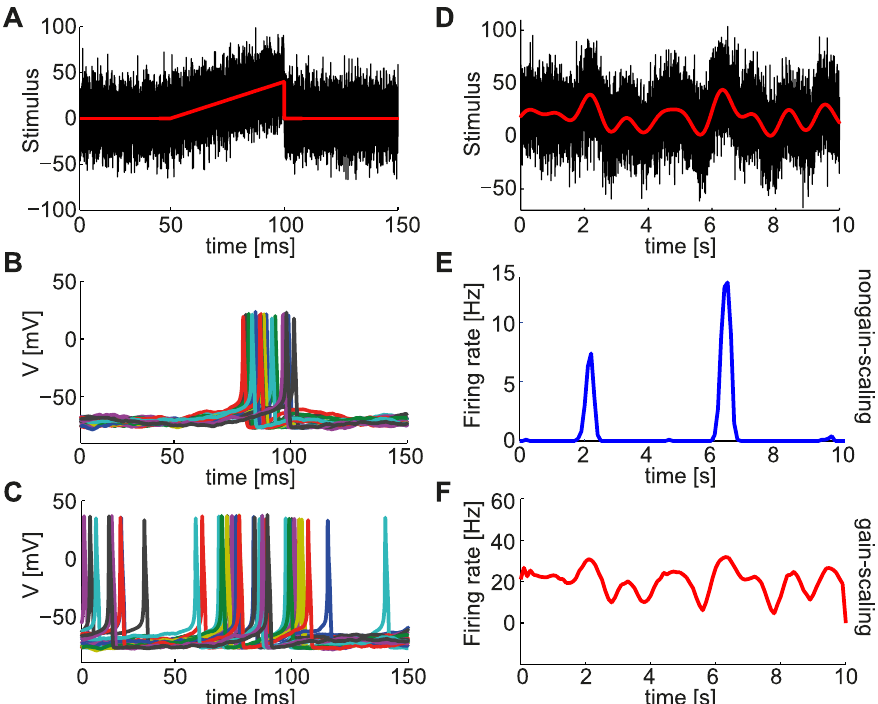
Figure 3. Stimulus encoding varies with the intrinsic properties of neurons. A . Noise fluctuations (black) superimposed on a short ramping input stimulus (red) with rise time of 50 ms were presented to two separate populations of 100 independent conductance-based model neurons with different gain-scaling properties. B,C . Voltage responses of (B) 100 NGS ( G K ~ 1000 pS/ m m 2 and G Na ~ 600 pS/ m m 2 ) and (C) 100 GS neurons ( G K ~ 1000 pS/ m m 2 and G Na ~ 1500 pS/ m m 2 ) to the ramp input in A. The different colors indicate voltage responses of different neurons. D . Noise fluctuations with a correlation time constant of 1 ms (black) superimposed on a Gaussian input stimulus low-pass filtered at 500 ms (red) for a duration of 10 seconds were also presented to the two neuron populations. E,F . Population response (PSTH) of NGS (E) and GS (F) neurons to the input in